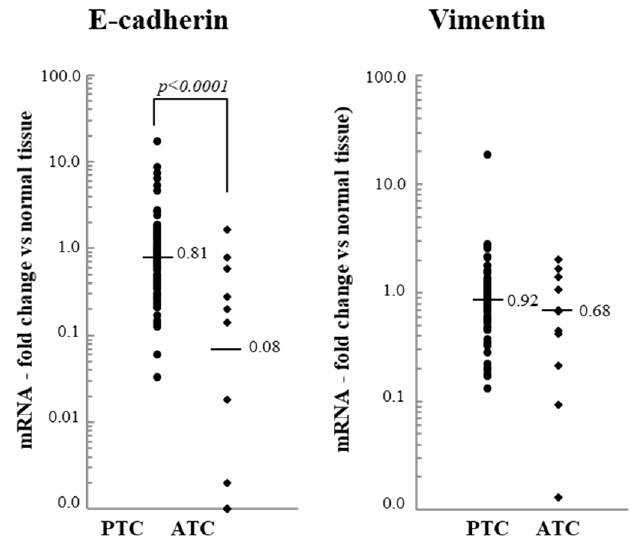
Figure 5. The E-cadherin and vimentin mRNA levels of 95 papillary thyroid cancer (PTC) and 12 anaplastic thyroid cancer (ATC) tissues. The small bars represent the median with the values indicated. The dotted line represents the expression levels in normal tissues. Table 3. A univariate analysis of the EMT transcription factor expression and the clinicopathological features of 95 PTC patients. In parentheses is the number of patients. The median values of the mRNA fold change between PTC tissue and its normal counterpart are listed for each category of clinical parameters, except for patients’ ages, for which the correlation coefficients are reported. pT, tumor size; pN, lymph node metastasis: TNM, Tumor, Node, Metastasis staging system.